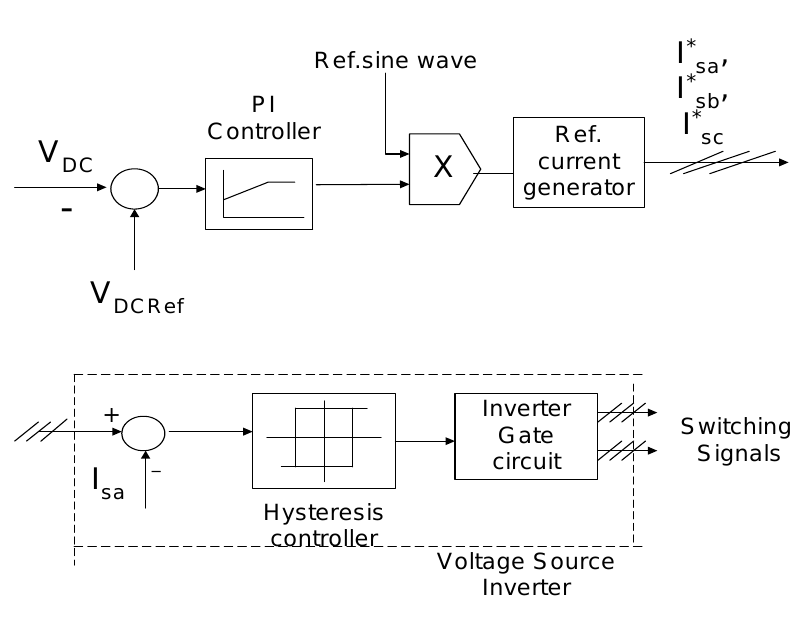
Figure 4. “Control Scheme block